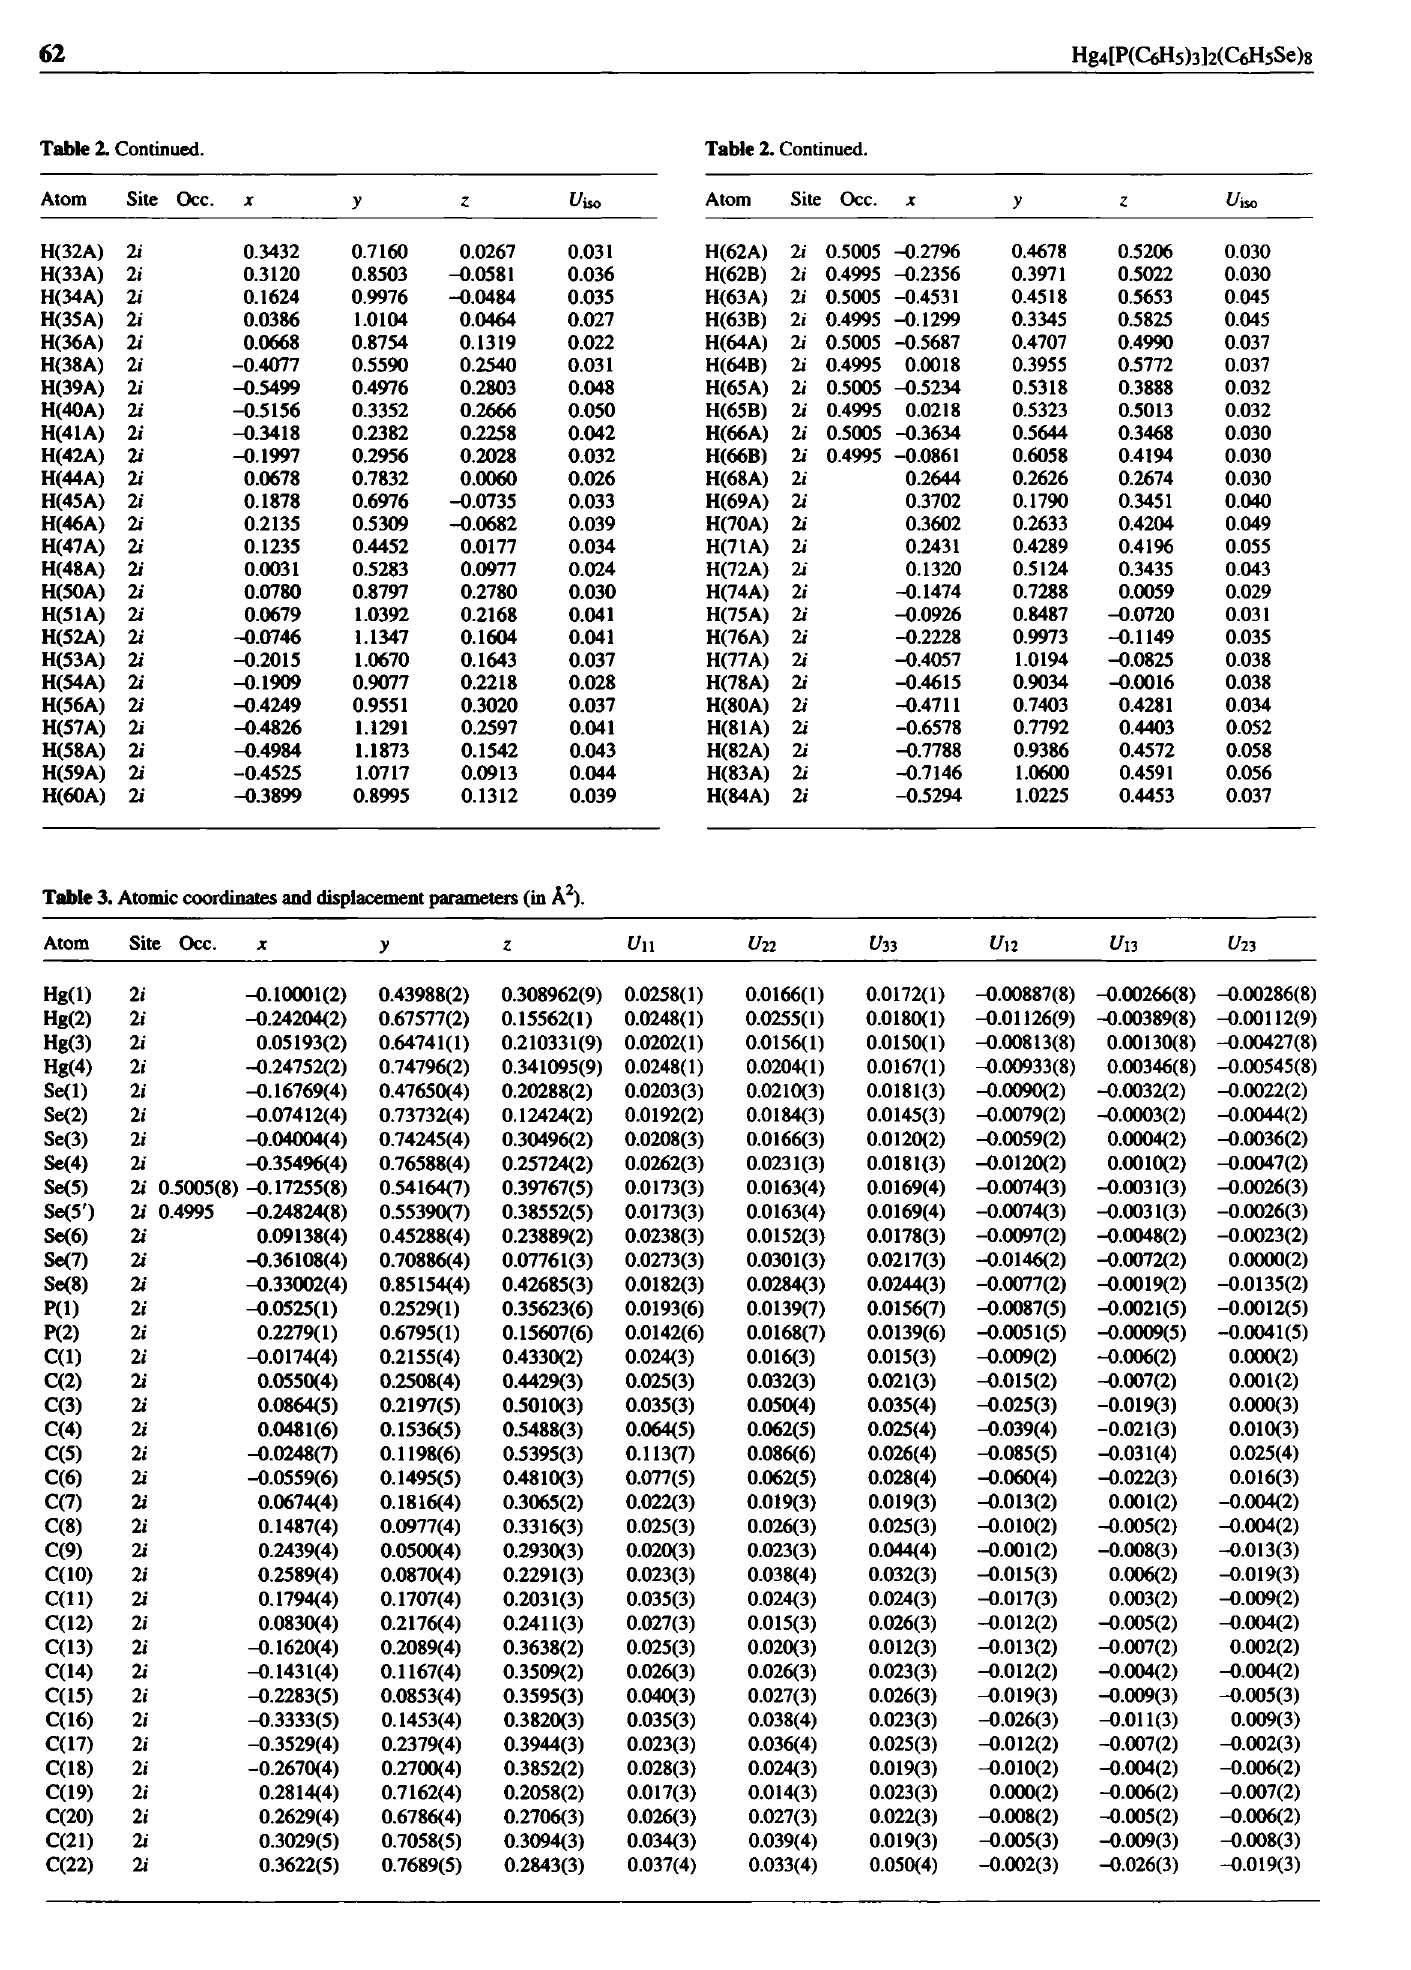
Table 3. Atomic coordinates and displacement parameters (in A 2